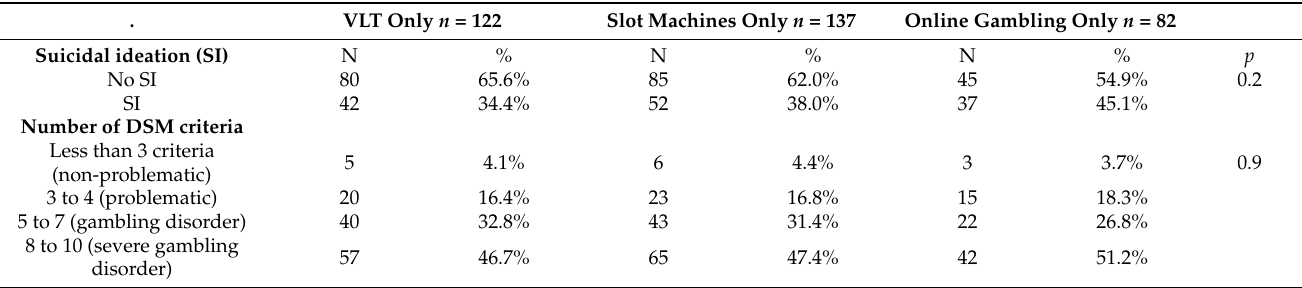
Table 3. Suicidal ideation and DSM IV criteria by player